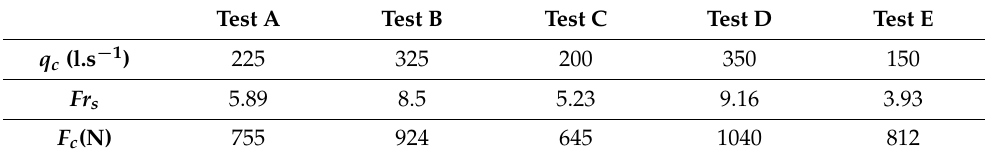
Table 2. Critical discharge, critical load and stone-related Froude number values for each experimental test. Test A Test B Test C Test D Test E